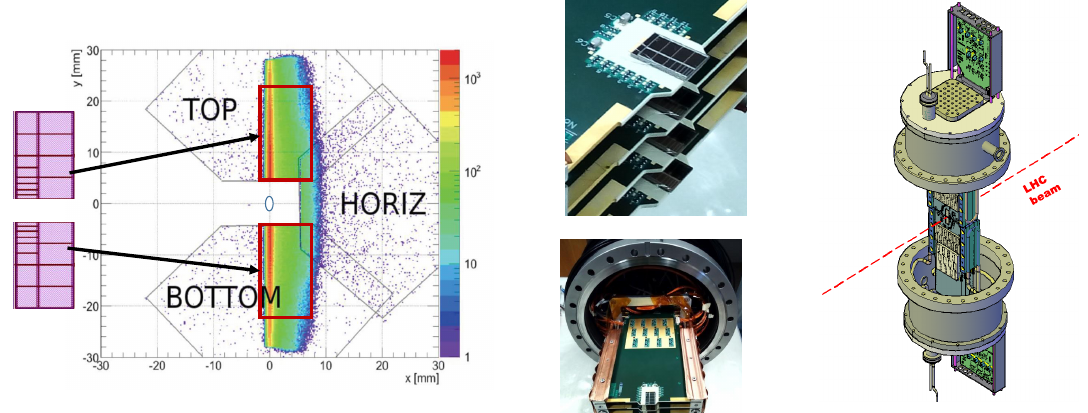
Figure 2. ( On the left ) the simulated distribution of protons in the RP area with the β ∗ = 90 m optics. The area covered by the sensor is highlighted. In the center is two pictures of the timing sensors hosted in one RP. ( On the right ) scheme of the detector inner mechanics for the vertical